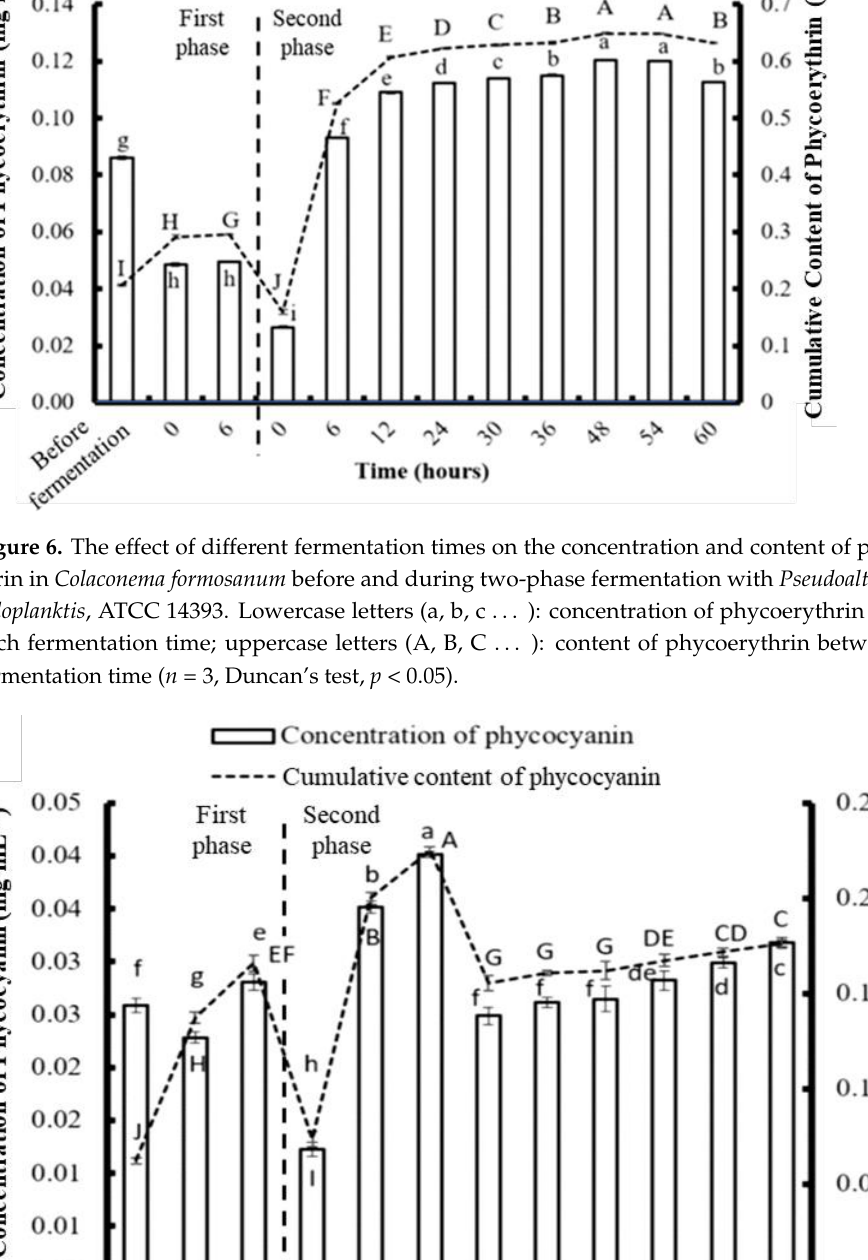
Figure 8. The effect of different fermentation times on the concentration and content of allophy- cocyanin in Colaconema formosanum before and during two-phase fermentation with Pseudoalter- omonas haloplanktis , ATCC 14393. Lowercase letters (a, b, c…): concentration of allophycocyanin